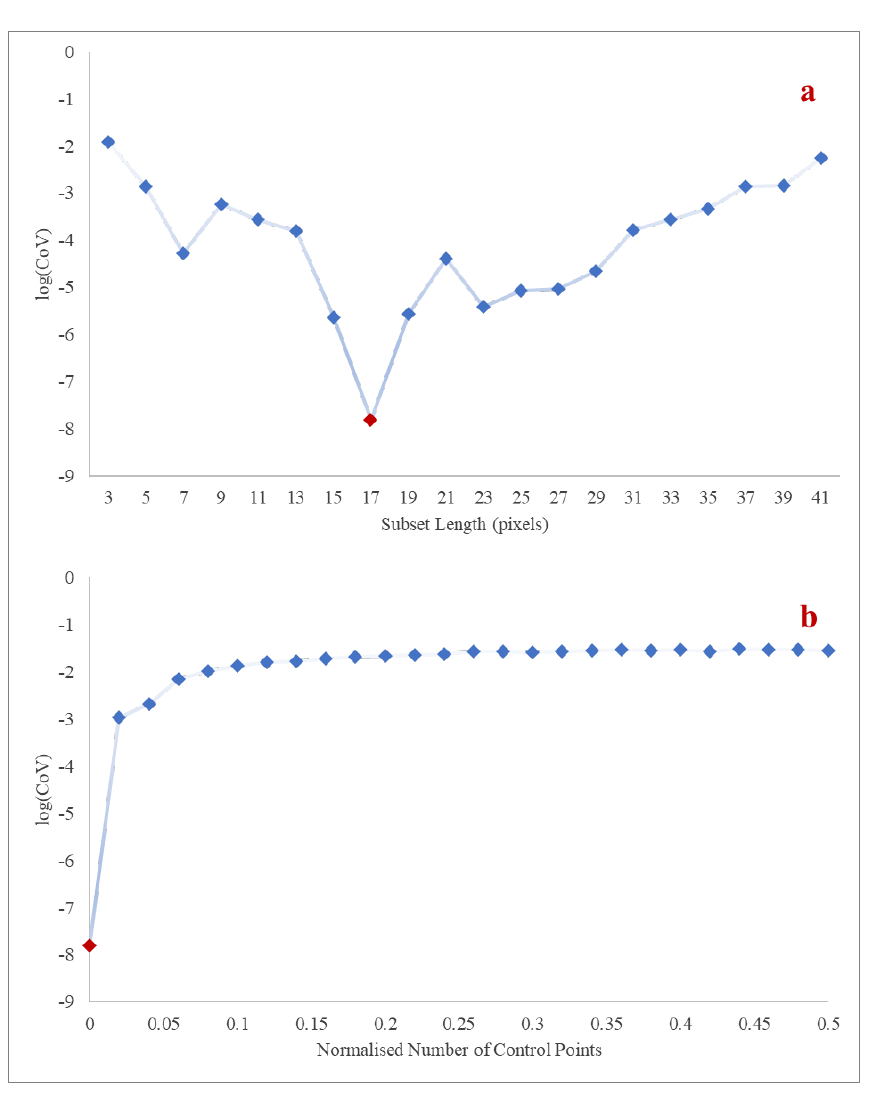
Figure 4. Variation of logarithm of the coefficient of variation (CoV) with respect to subset length ( a ) and normalised number of control points ( b ). There is a connection between ( a ) and ( b ) parts of this figure. The analysis on normalised number of control points is performed using the best subset length obtained after the analysis on subset length.